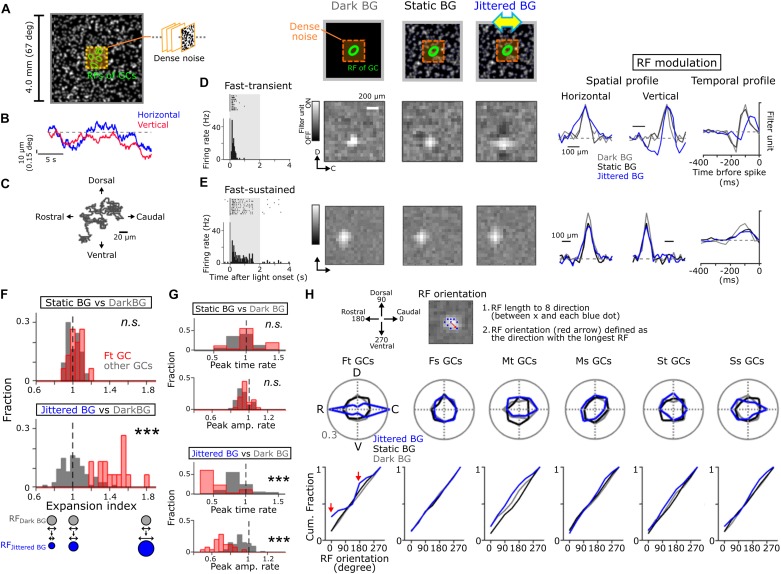
Global jitter motion alters the RF profiles of Fast-transient GCs. (A) A schematic of stimulus. Dense noise stimulus (orange, 1.6 × 1.6 or 0.96 × 0.96 mm) was presented on the random-dot background (4 × 4 mm, mean contrast; 45.6%, mean luminance; 6.67 cd/m2). The random-dot background was moved in four cardinal directions randomly (4 μm/50 ms; Jittered BG). (B) Examples of random-walk trajectory in the horizontal (blue) and vertical (red) directions. (C) 2D plots of the jitter motion trajectory (20 s). (D,E) Top, schematics of stimuli. Left, firing to a flash (gray band; size, 1 × 1 mm; duration, 2 s; 50% contrast increment) in Fast-transient (Ft) (D) and Fast-sustained (Fs) (E) GCs. Middle, the spatial RF profile under the Dark (gray), Static (black), and Jittered (blue) BG conditions. Right, the spatial and temporal RF profiles (upper, Ft GC; lower, Fs GC). (F,G) Expansion index panel (F) and temporal RF profile (G; upper, peak time; lower, peak amplitude): top, Static BG vs. Dark BG; bottom, Jittered BG vs. Dark BG. Fraction was calculated separately for Ft GCs (red, n = 17) and other GCs (gray, n = 73). (H) Top, a schematic for calculation of the RF orientation. The RF orientation was determined as a direction (red arrow) with the longest RF length (between × and blue dots). Middle; polar plot of the RF orientation under the Dark (gray), Static (black), and Jittered (blue) BG conditions for each GC group: 17 Ft GCs, 16 Fs GCs, 10 Medium-transient (Mt) GCs, 14 Medium-sustained (Ms) GCs, 14 Slow-transient (St) GCs, and 19 Slow-sustained (Ss) GCs. Bottom; cumulative fraction of the RF orientation. Red arrows; cumulative fraction at the horizontal axis (0 and 180 degree) under the Jittered BG condition. ∗∗∗p < 0.001. See also Supplementary Figure S1 for physiological and morphological features of each GC group, and Supplementary Figure S2 for visual stimulation.